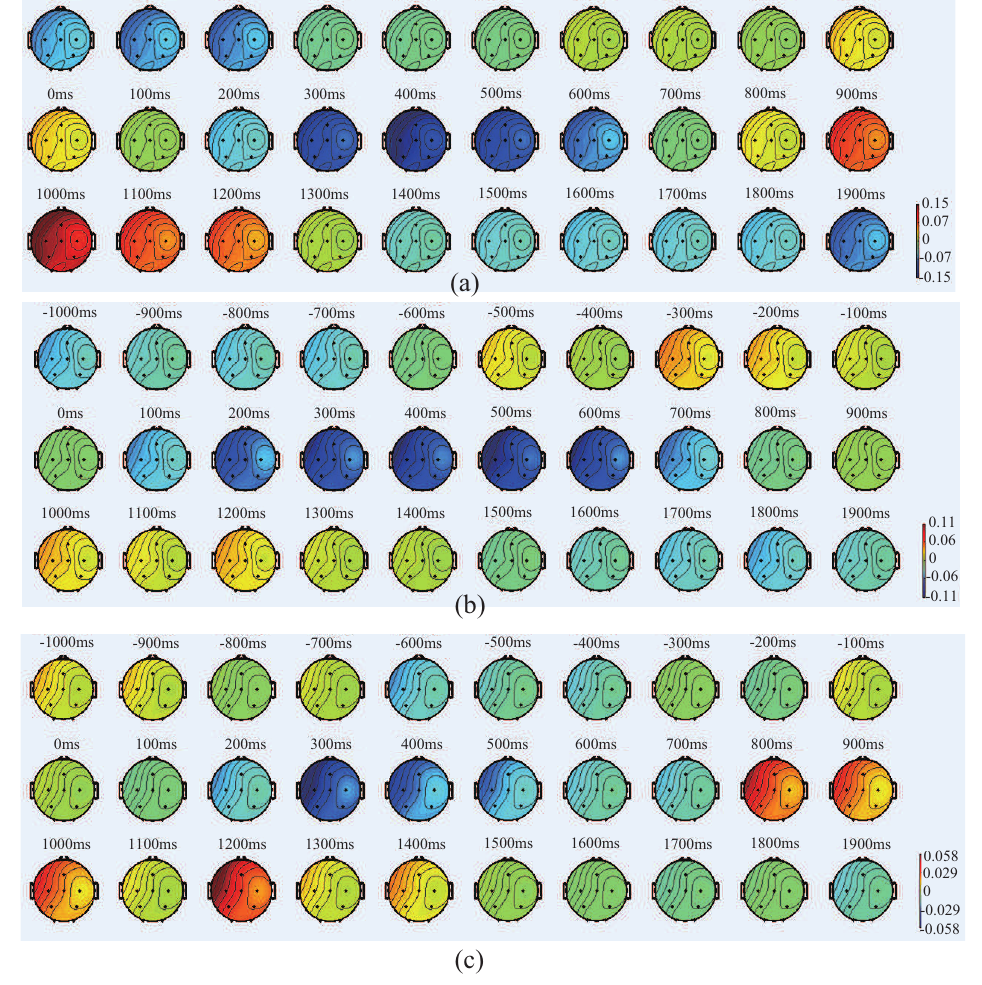
Figure 11. Timing diagram of the averaged EEG signals. In the ( a – c ) represents the results of three subjects, respectively. The data of 3 s for each subject is divided into three rows, corresponding to 1 s before the motion, 1 s after the start of the motion and 1 s to 2 s after the motion starts. The colors in the figure correspond to the amplitude of processed EEG